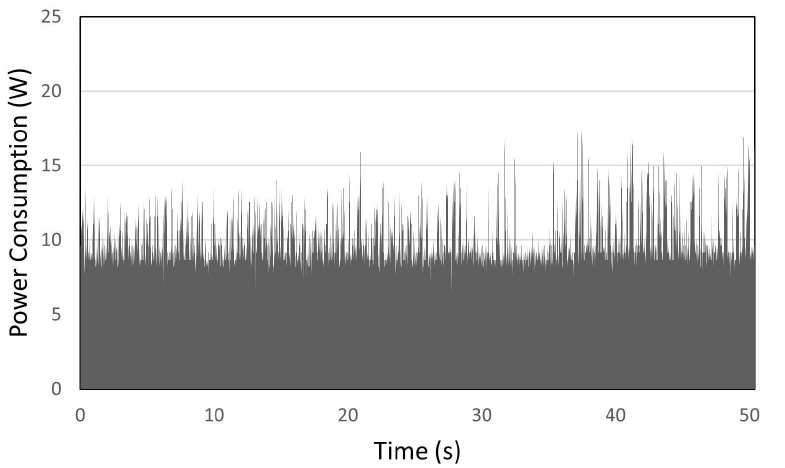
Figure 9. IASE Power consumption over